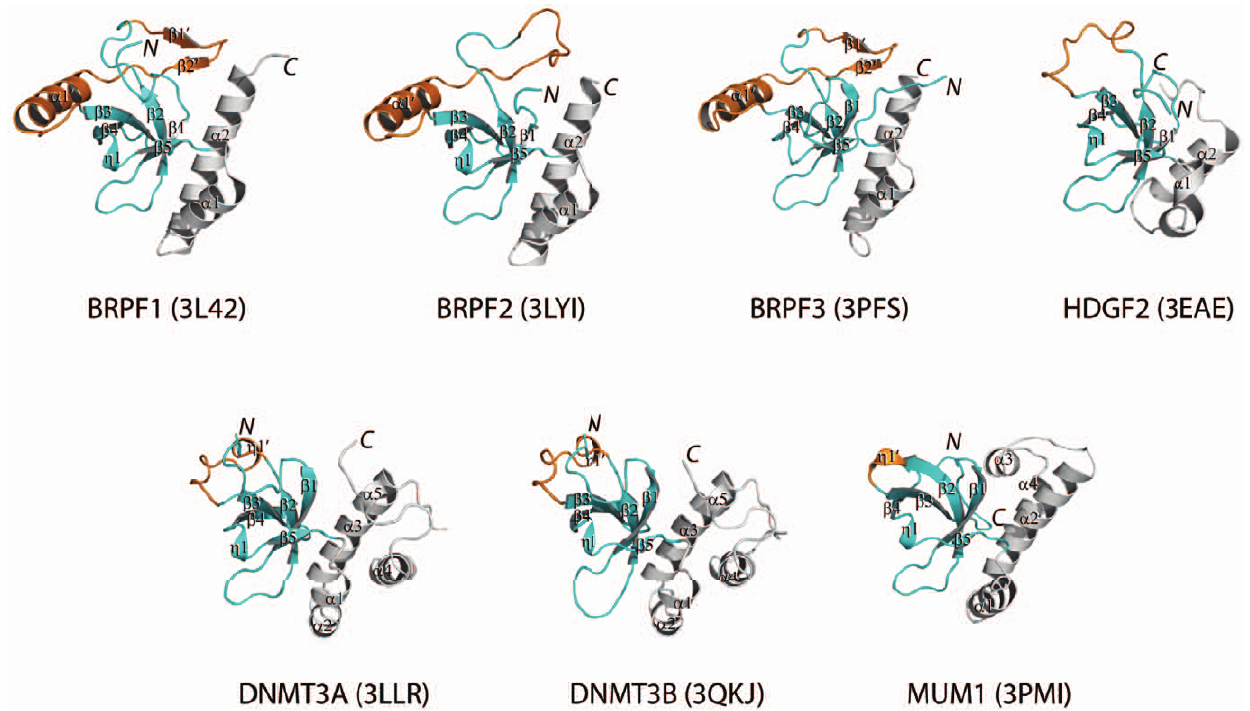
Figure 2. Crystal structures of the seven human PWWP domains reported in this study. PWWP fold consists of three structural elements: the canonical core (colored in cyan) comprising 5 b -strands, which highly resembles the Tudor domain fold, an insertion motif between the second and third b strands (colored in orange) and the PWWP characteristic C-terminal a helix motif consisting of 1–5 a -helixes (colored in grey). The figure was generated by Pymol.